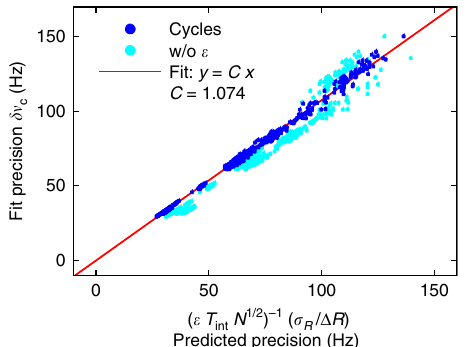
Figure 6 | Predictability of the precision. The precision of the central frequency n c as obtained from a line shape fit to a cycle is plotted against the quantities, which enter the proportionality formula (5). A line fit (red line) through the origin extracts the proportionality constant C , which should be equal to 1. All 545 cycles recorded within the ten sets are included in this plot. The dark and bright blue dots depict the situation when the correction factor e is included or omitted, respectively.